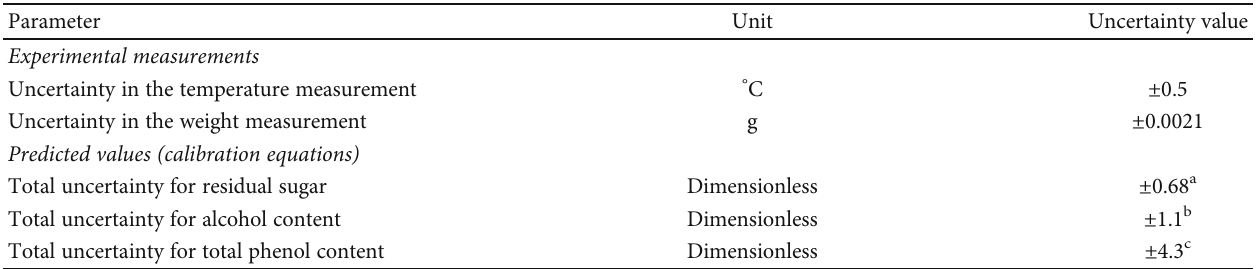
Table 3: Uncertainties of the experimental measurements and total uncertainties for predicted values.